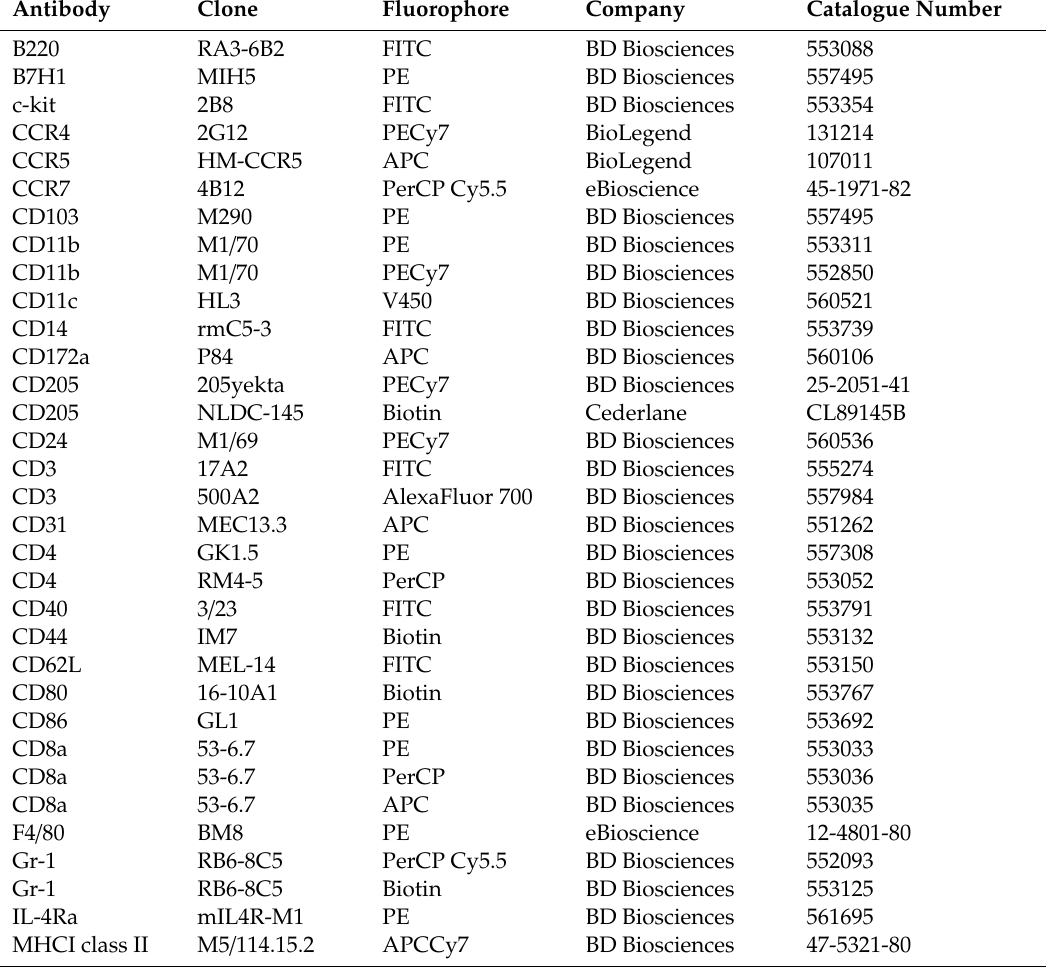
Table 1. List of flow cytometry